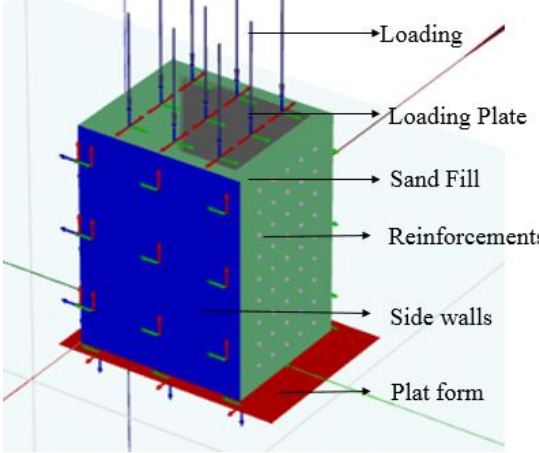
Figure 8. Three dimensional numerical models with description.